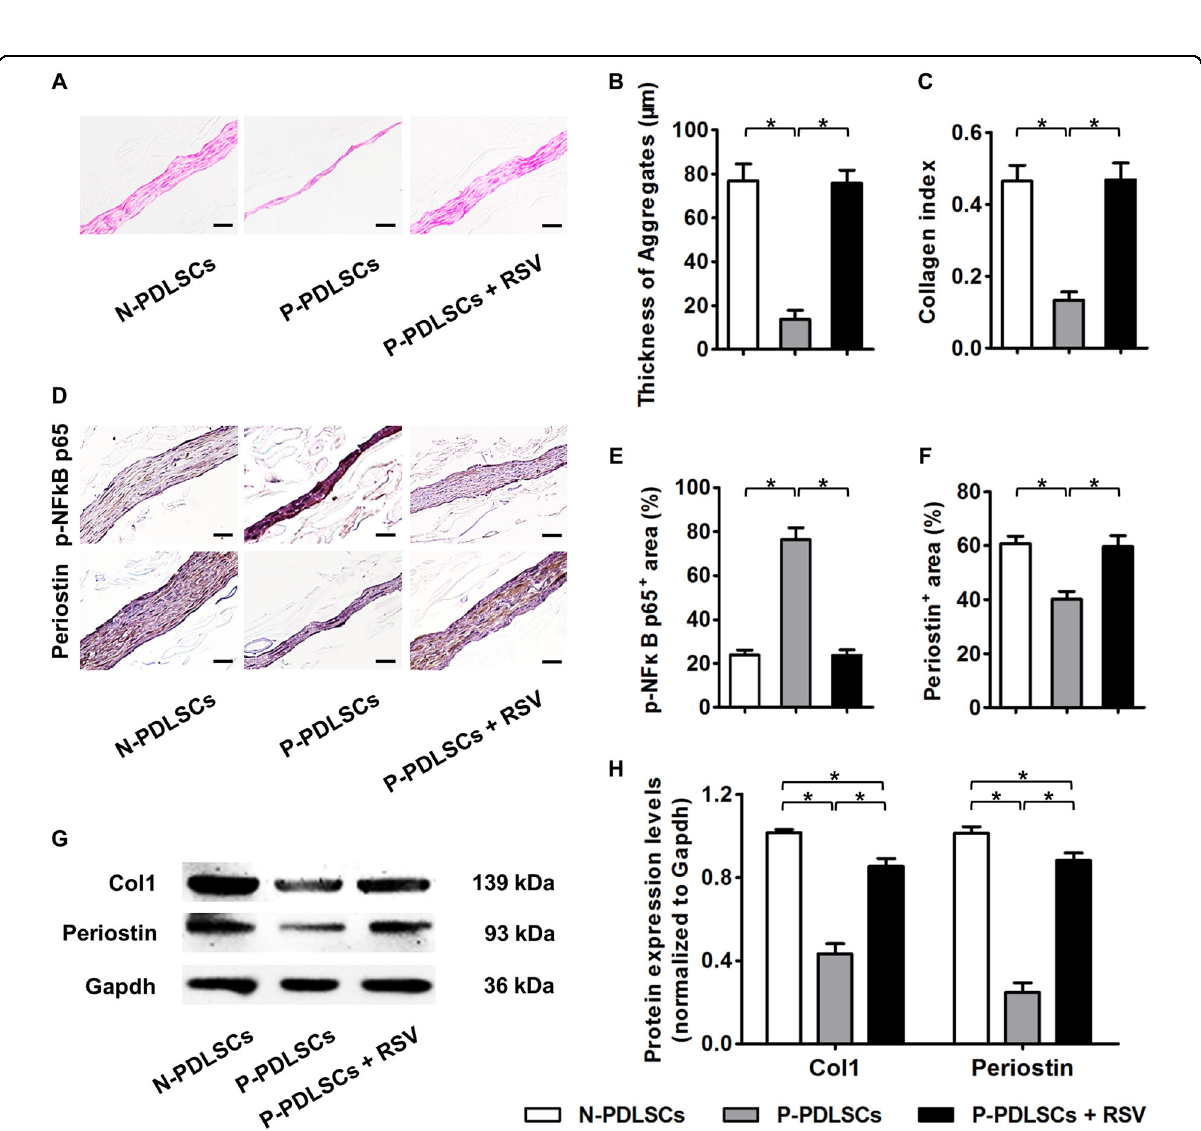
Fig. 4 RSV treatment promoted the cell aggregate formation of P-PDLSCs. a – c Histological analysis of PDLSC aggregates ( a ) showed that RSV treatment promoted the cell aggregate formation ( b ) and collagen deposition ( c ) of P-PDLSCs. Bars: 50 μ m. d – f Immunohistochemistry analysis of the key molecule of the NF κ B pathway, p-NF κ B p65, and the ECM marker gene Periostin in PDLSC aggregates ( d ). The data showed that RSV treatment suppressed the NF κ B pathway ( e ) and improved ECM formation ( f ) in P-PDLSC aggregates. Bars: 50 μ m. g Western blot analysis of the ECM marker genes Col1 and Periostin in PDLSC aggregates. h Western blot analysis showed that RSV improved ECM deposition in P-PDLSC aggregates. RSV was applied at 10 nM throughout the experiments. n = 6 per group ( a – f ) and n = 3 per group ( g , h ). The data represent the mean ± SD. * P <